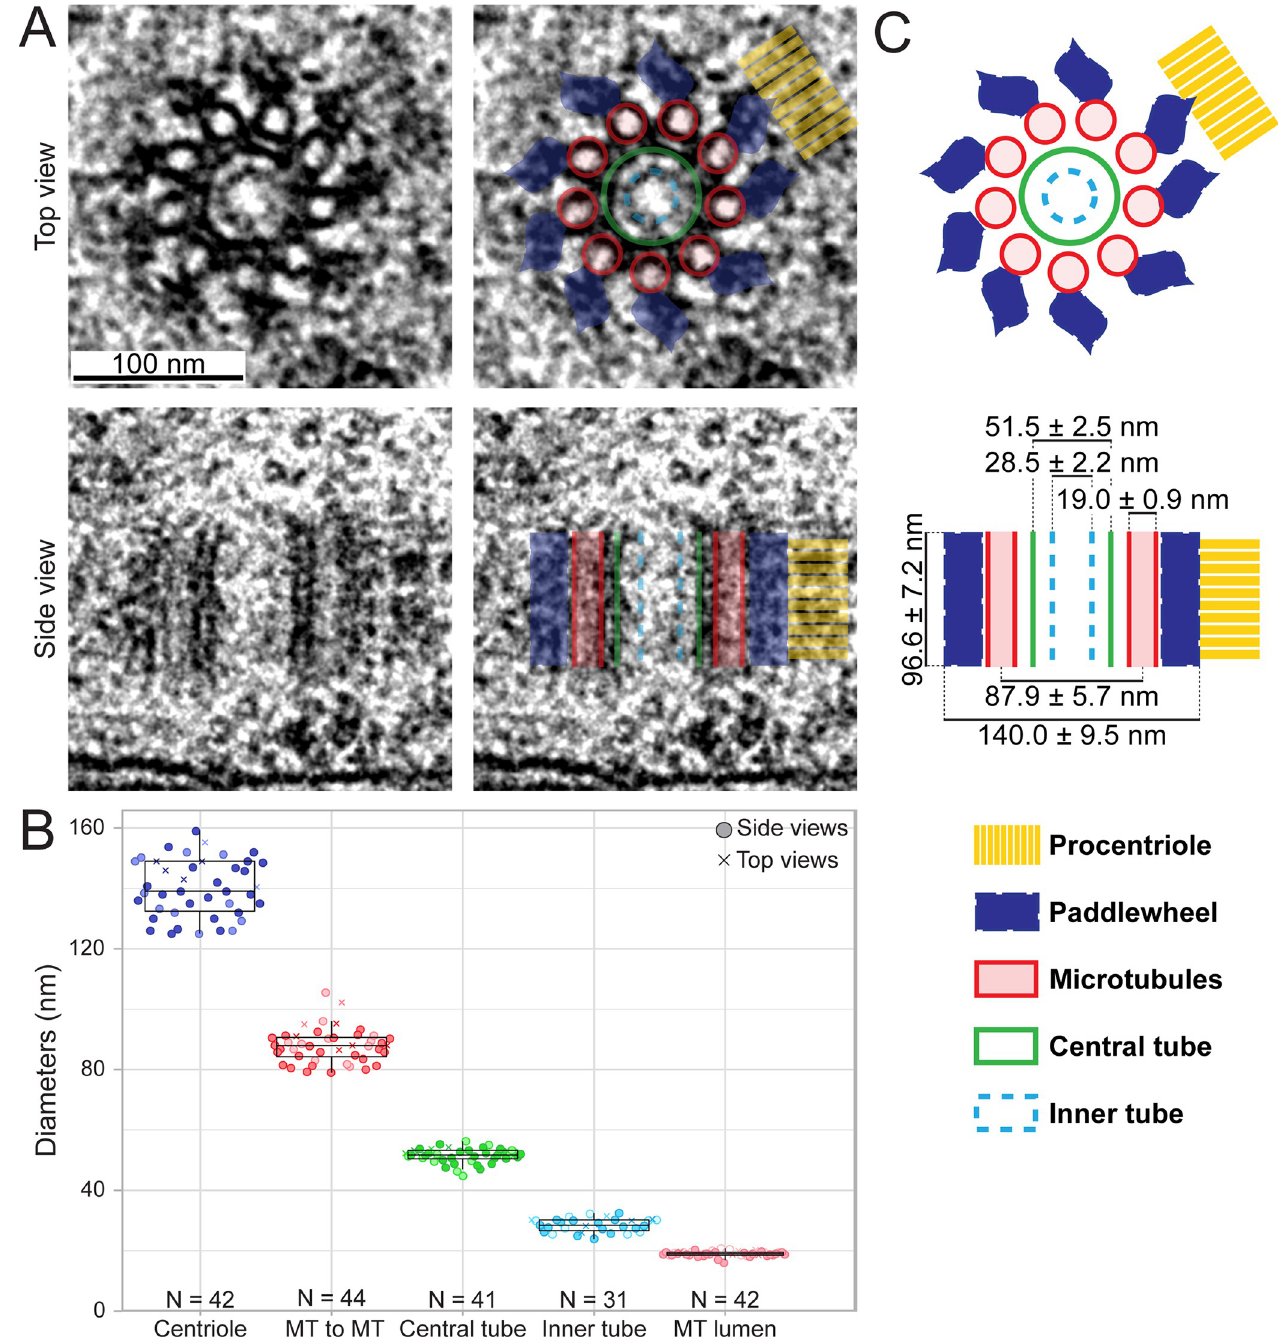
Fig 5. EM analysis of the centriole in the gonad. (A) (Left) EM of top and side views, as indicated, of early meiotic prophase centrioles. (Right) Overlay with distinct ultrastructural compartments as described in (C). (B) Diameters of ultrastructural compartments of the gonad centriole. Top view (crosses) and side views (circles) were analyzed; light and dark shade of colors represent data points from 2 independent samples. The middle line of the boxplots corresponds to the median, the box includes 50% of values (IQR), and the whiskers show the range of values within 1.5 � IQR. (C) Schematic representation of top and side views of centrioles with ultrastructural compartments depicted in colors, as well as average measurements ± SD (see also C). N = 38 for centriole height. Data underlying the graphs shown in the figure can be found in S1 Data. EM, electron microscopy; SD, standard deviation.